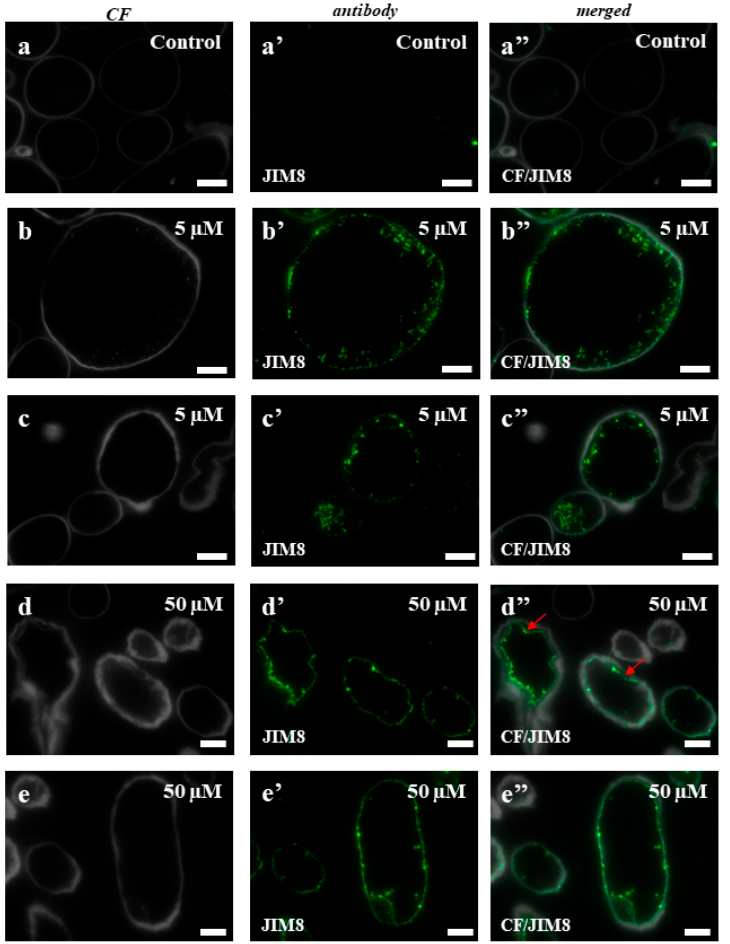
Figure 5. Immunolocalization of JIM8 in the Brachypodium callus. ( a – a” ): control callus; ( b – b” ), ( c – c” ): callus that has been treated with 5 µM of 5-azaC. ( d – d” ), ( e – e” ): callus that has been treated with 50 µM of 5-azaC. ( d” ): red arrows demonstrate the detachment of the plasmalemma from the cell wall. Scale bars, 10 µm.